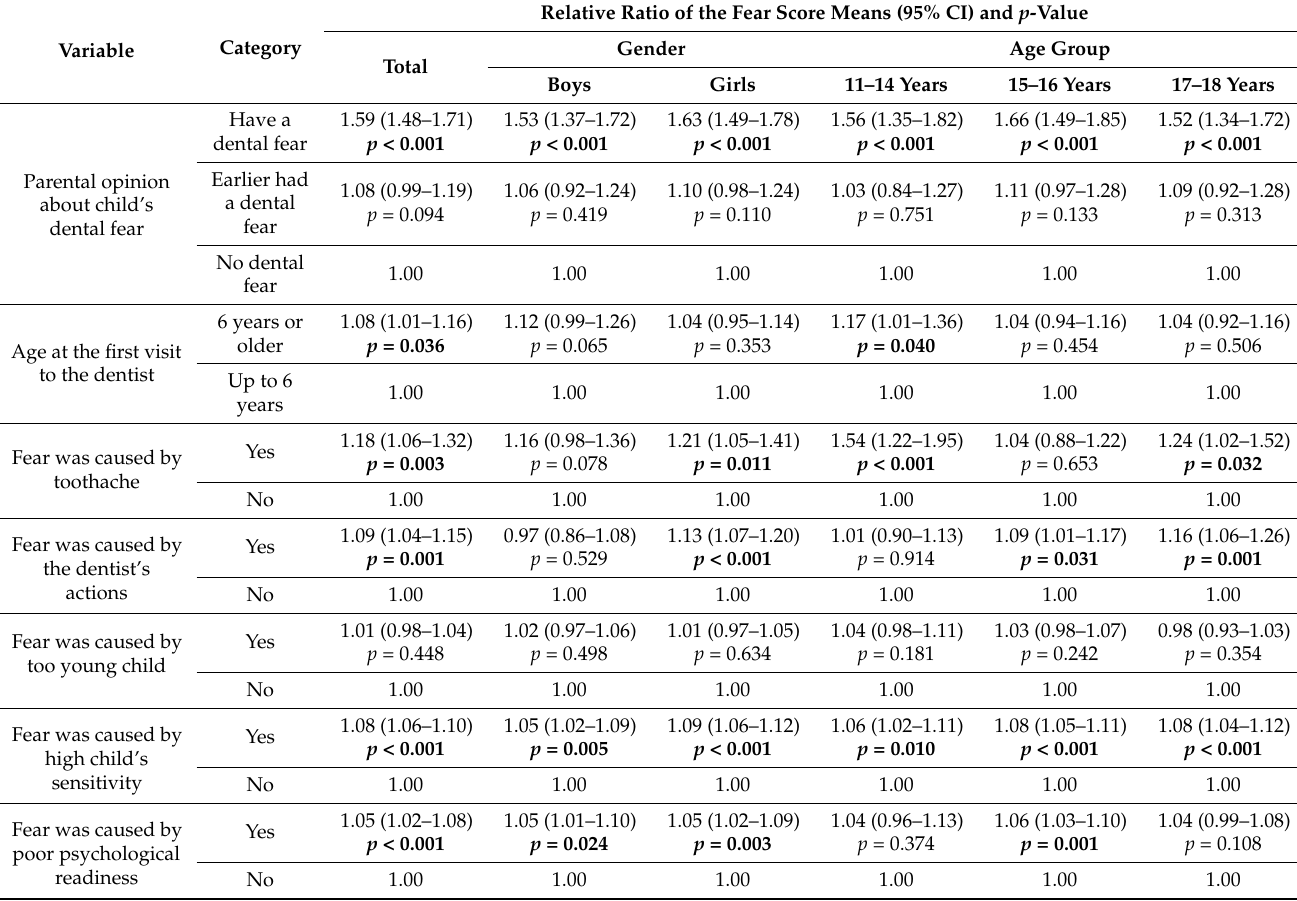
Table 7. Association of child and adolescent dental fear with variables reported by parents. Relative Ratio of the Fear Score Means (95% CI) and p Variable Category